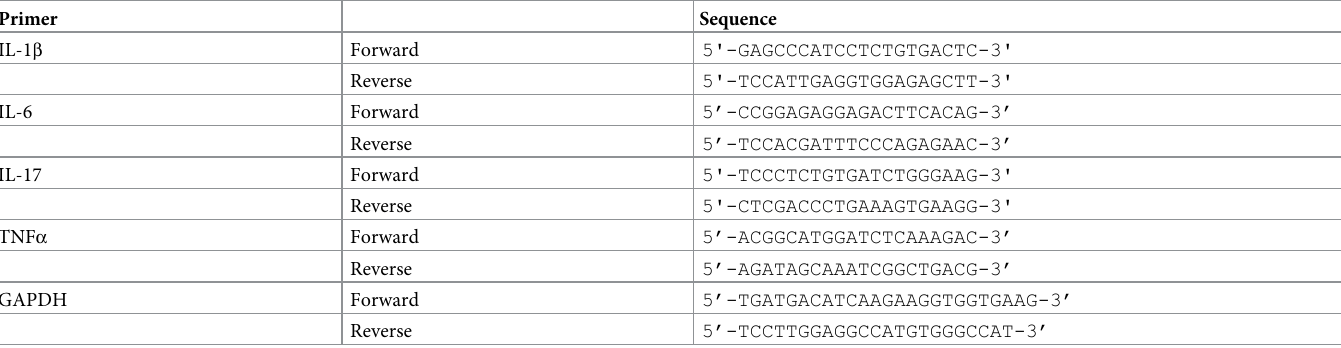
Table 1. Primer sequences of the Reverse Transcription Polymerase Chain Reaction (real time-PCR). Primer Sequence IL-1